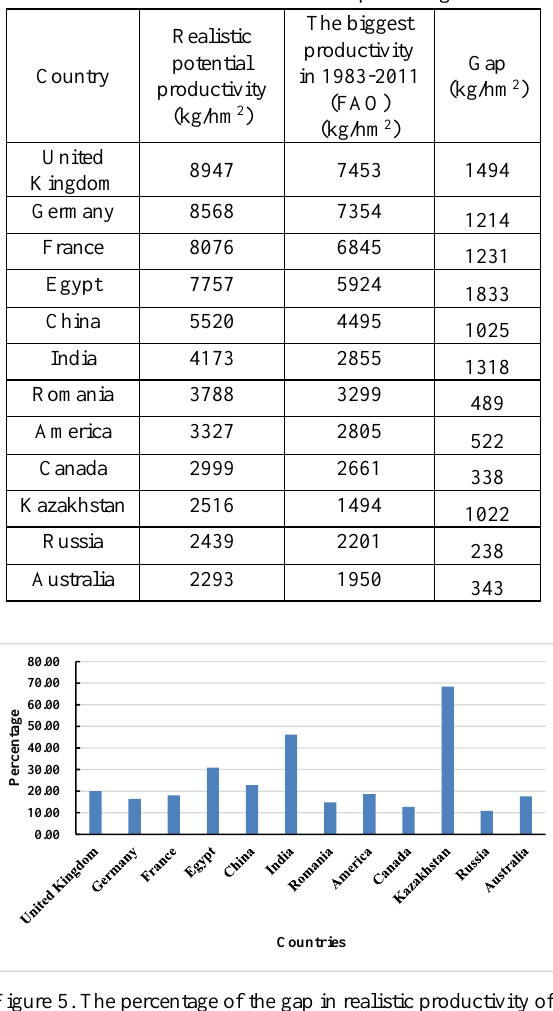
Figure 5. The percentage of the gap in realistic productivity of winter wheat in different